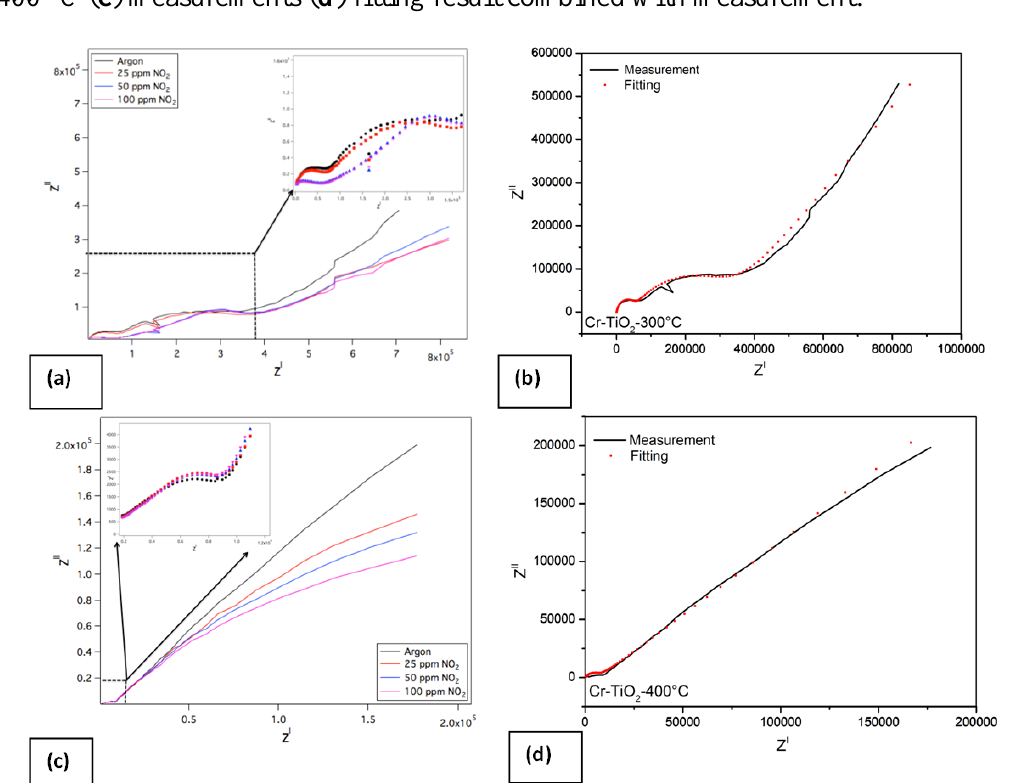
NTs under different concentrations of 2